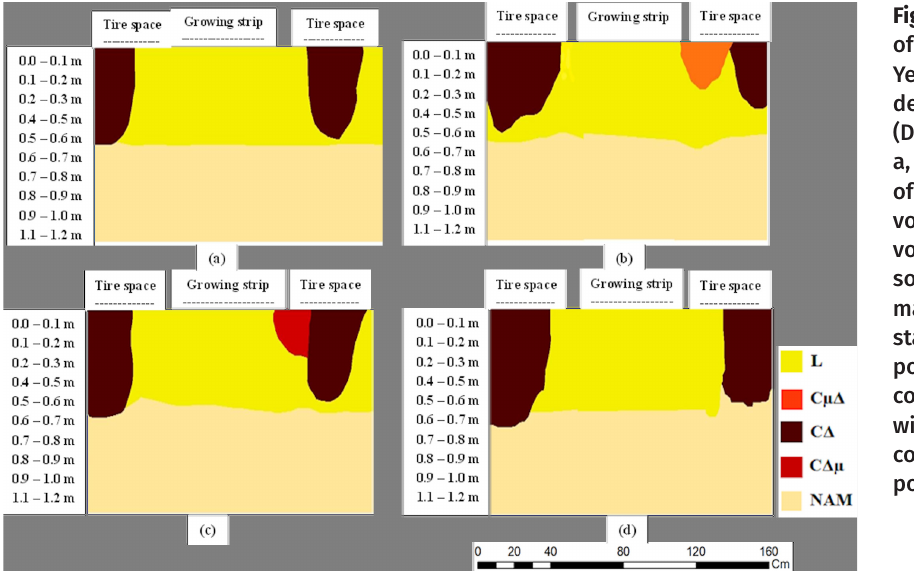
Figure 2. Cultural profiles of a dystrophic Red- Yellow Latosol under deep localized soil tillage (DLST). Field